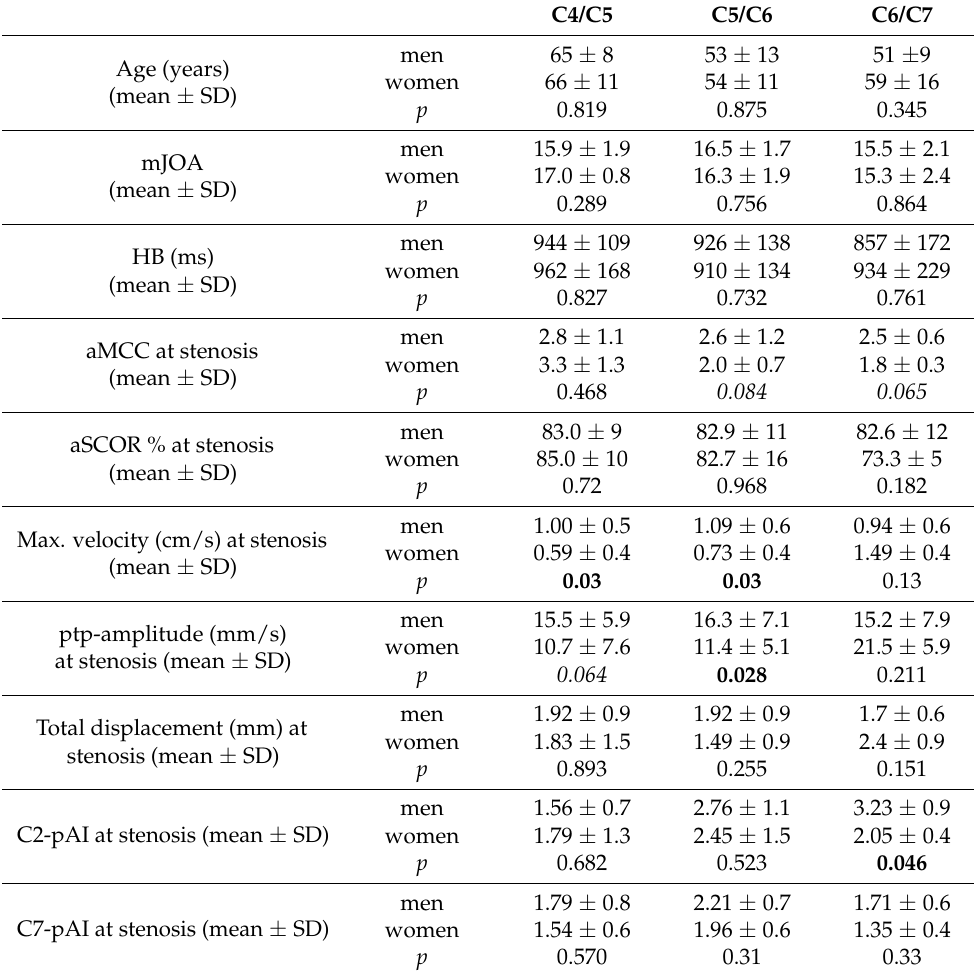
Table 2. Clinical, anatomical, and spinal cord motion data per suitable group of patients divided by